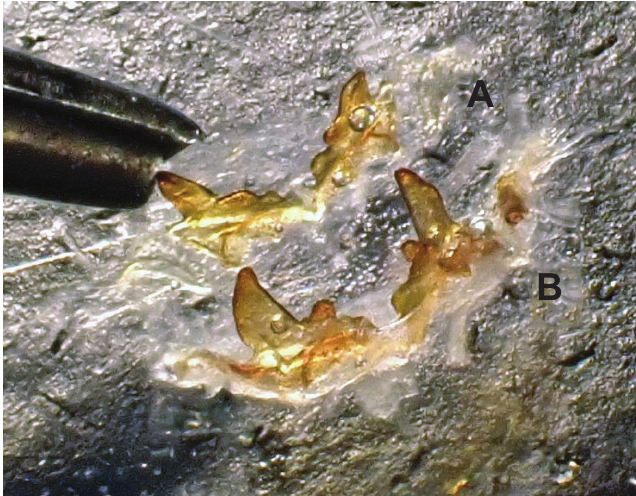
Fig. 5. Anterior axial view as epiphallus as situated when looking at opened apex of abdomen. A. Burttia sylvatica ; B. B. caerulea sp.